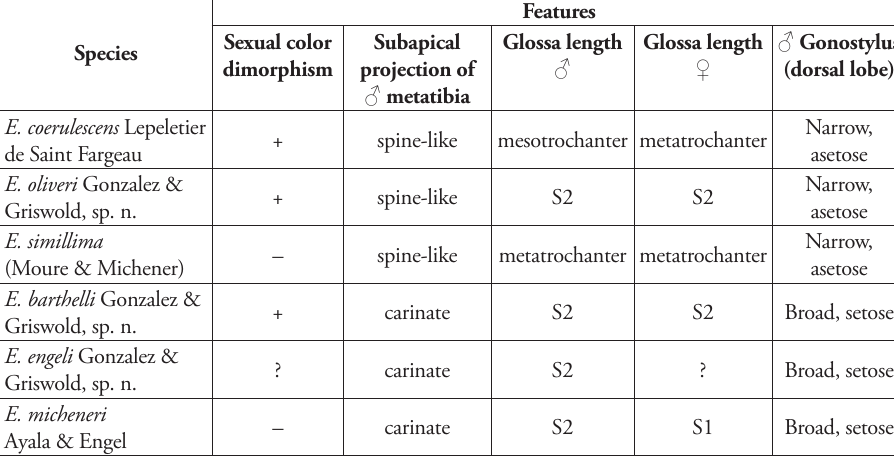
Table 1. Summary of currently included species in the coerulescens group of Eufriesea with information on some morphological features. Plus (+) and dash (–) symbols indicate presence and absence, respec- tively, of a particular feature, ? =